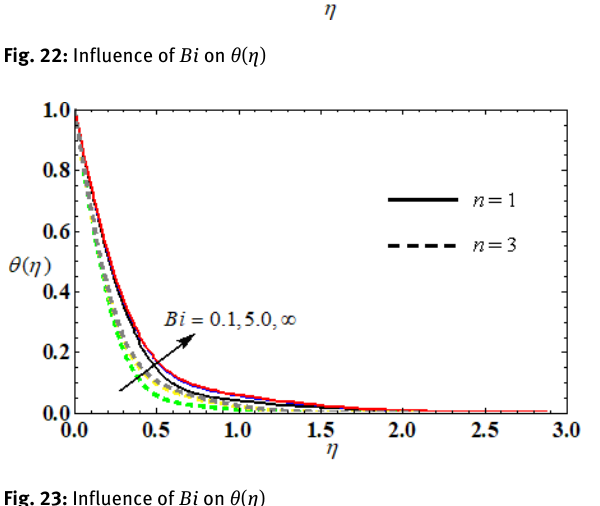
Fig. 23: Influence of Bi on θ ( η )